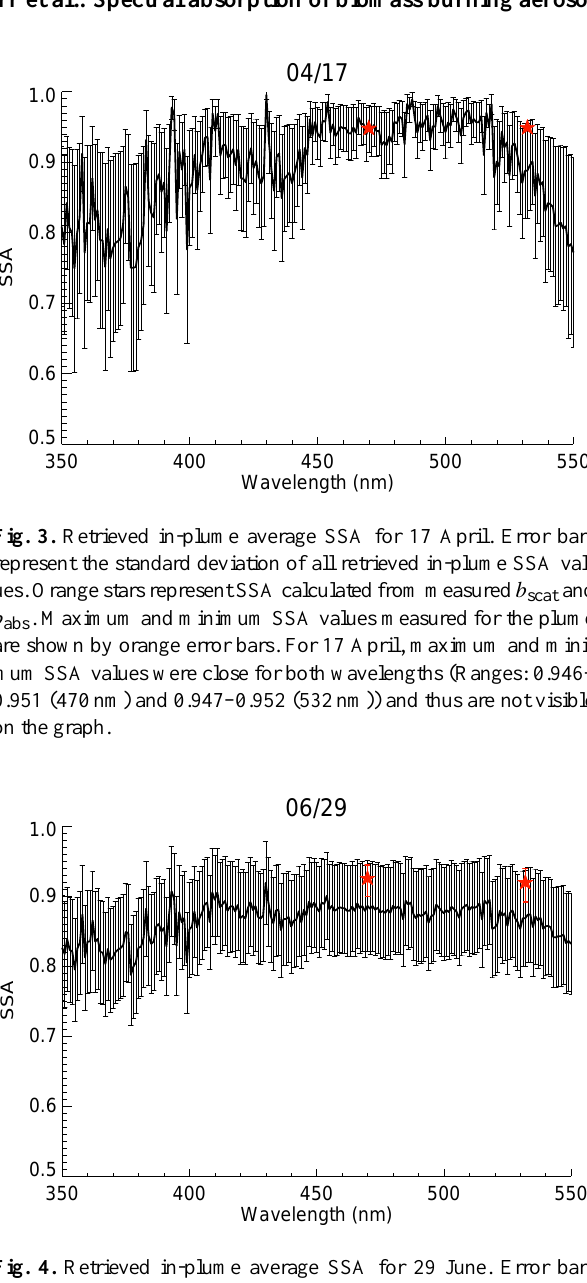
Fig. 4. Retrieved in-plume average SSA for 29 June. Error bars represent the standard deviation of all retrieved in-plume SSA val- ues. Orange stars represent SSA calculated from measured b scat and b abs . Maximum and minimum SSA values measured for the plume are shown by orange error